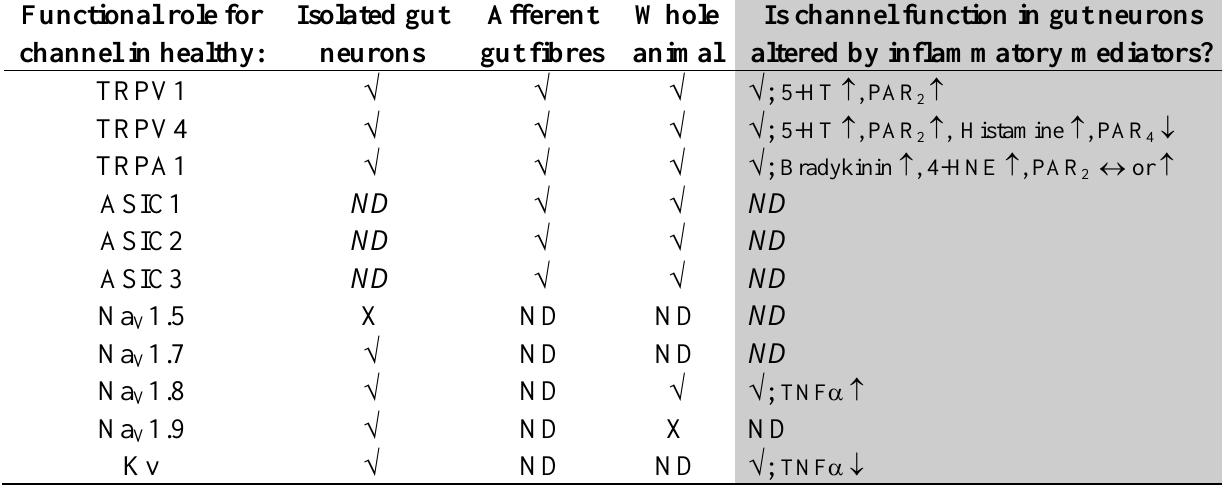
Table 1. Summarizes the ion channels implicated in signaling gut based “physiological” pain in healthy conditions and details where (gut innervating neurons, gut innervating afferents or whole animal gut based recordings) this function was demonstrated. This table also documents interactions of these channels with inflammatory mediators,